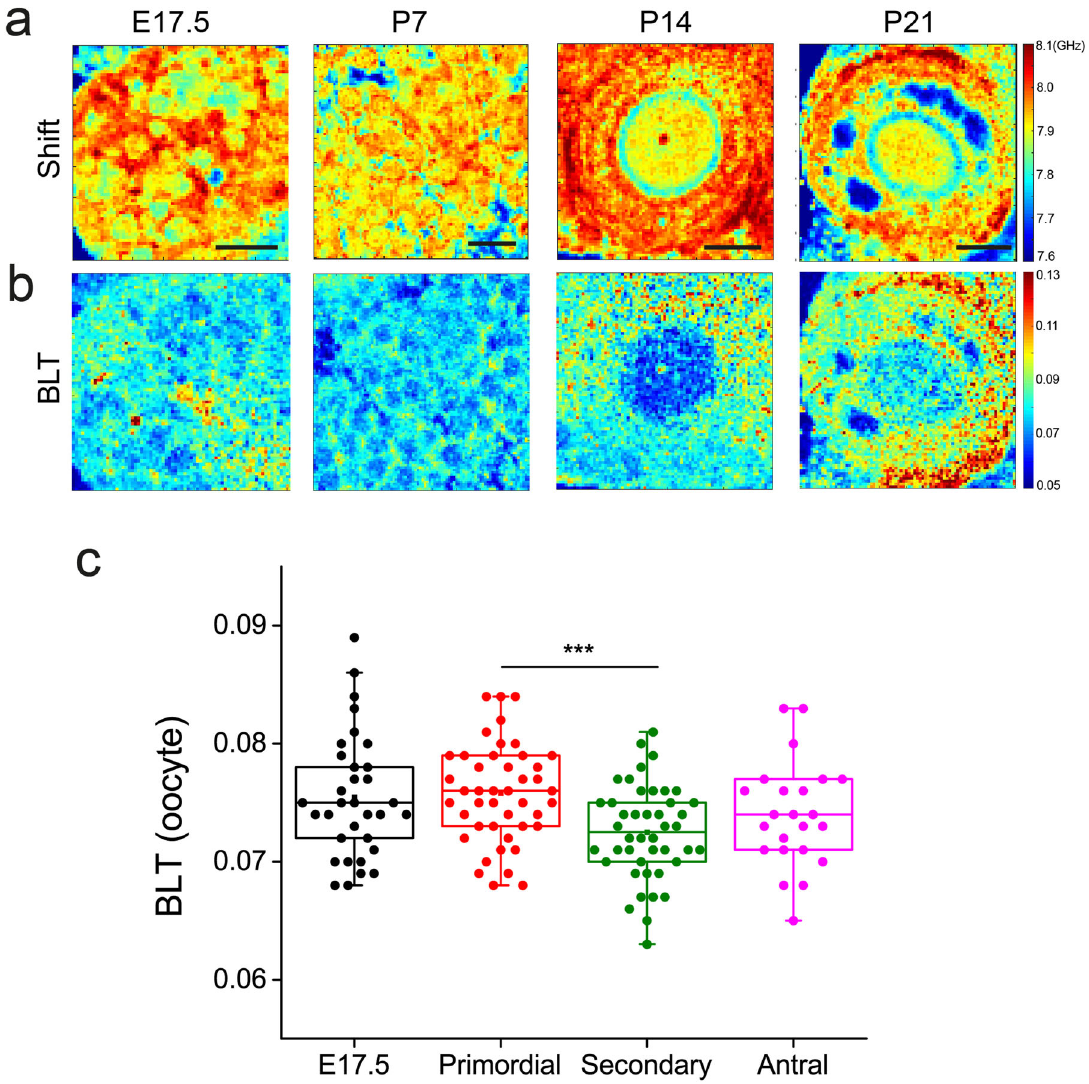
Fig. 4 Ooplasm exhibits more liquid-like behavior at the early stages of oogenesis. a Row shows representative maps of Brillouin shift for oocytes from fetal ovaries (E17.5), primordial follicles (P7), secondary follicle (P14) and antral follicle (P21) ovaries. Scale bar = 40 μ m. Blue regions within the antral follicle (P21) indicate fl uid lumena. b Corresponding Brillouin loss tangent for a . c Boxplot of BLT for oocytes at various stages of follicle development. Each data point corresponds to the average signal of one oocyte. N = 35, 45, 45, 21 for E17.5 germ cells and oocytes from primordial, secondary, and antral follicle stage, respectively. *** P <